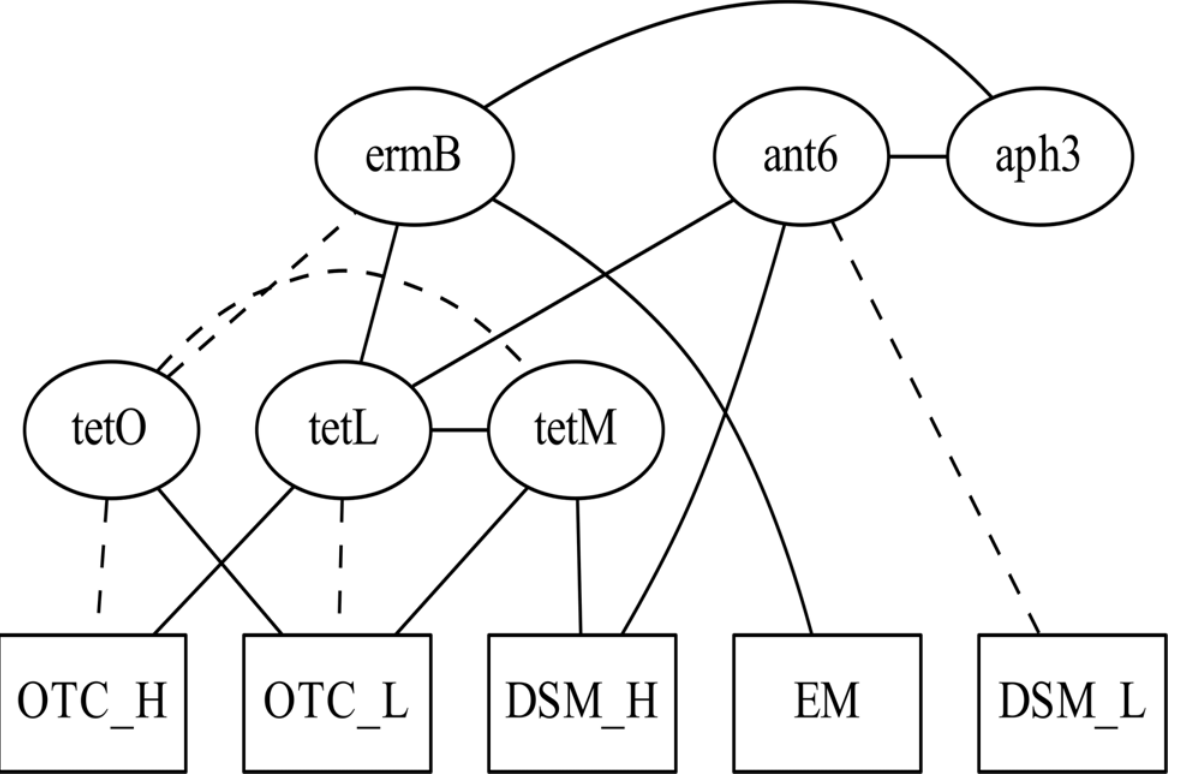
Fig 3. Final globally optimal additive Bayesian network model after adjustment for over-fitting. Final additive Bayesian network model after removing arcs that appeared in < 50% of bootstrappings for the interrelationships between selected antimicrobial resistance genes and phenotypes. Solid lines and dashed lines represent positive and negative associations between variables, respectively. Fig. 2 lists the variable